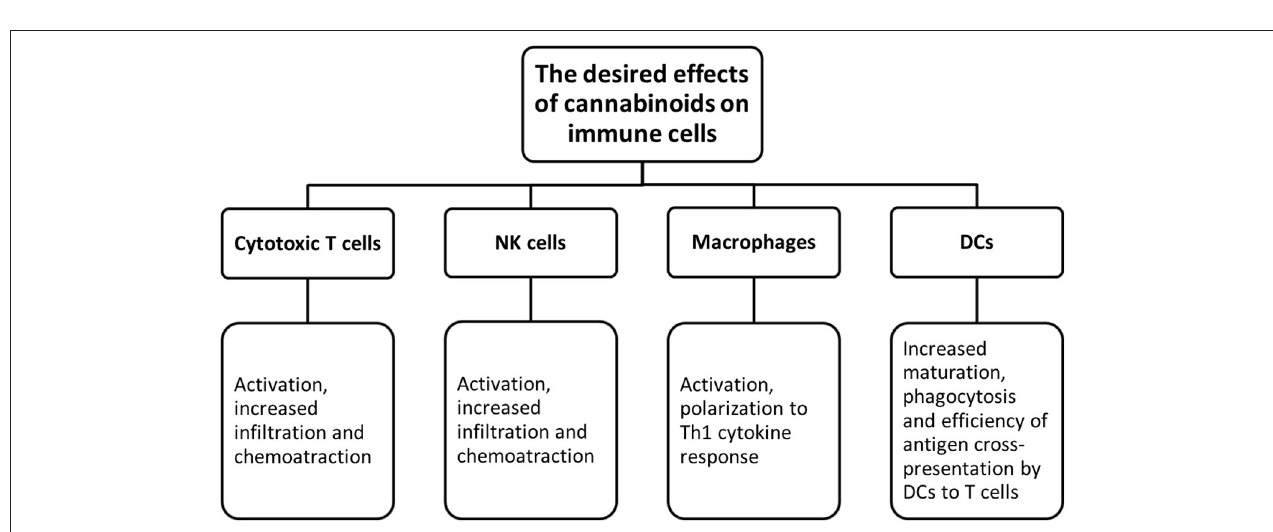
FIGURE 3 | The desired effects of cannabinoids on immune